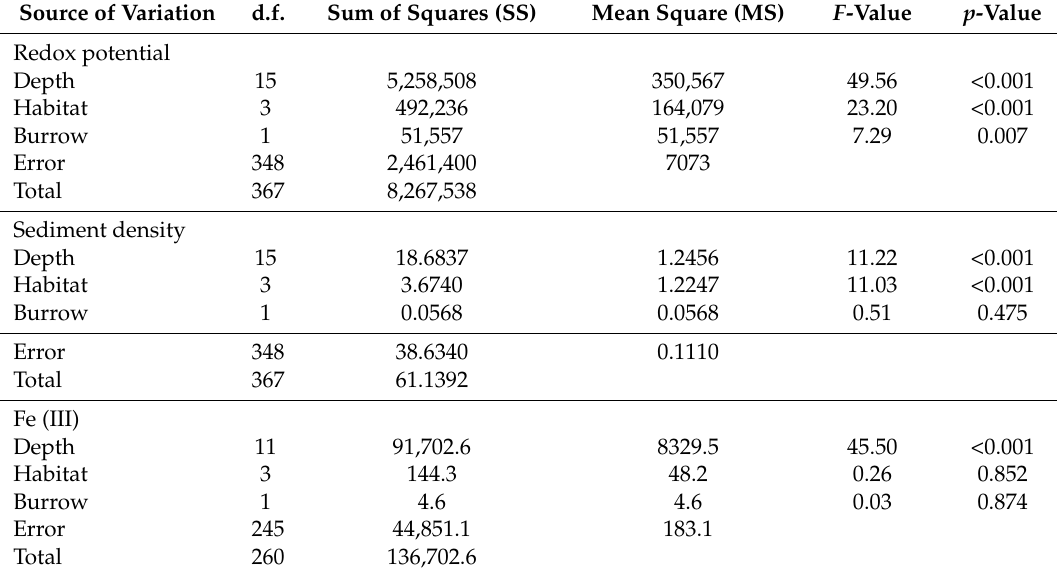
Table 1. Analysis of variance (ANOVA) for sediment properties among depth, habitat and burrow. Source of